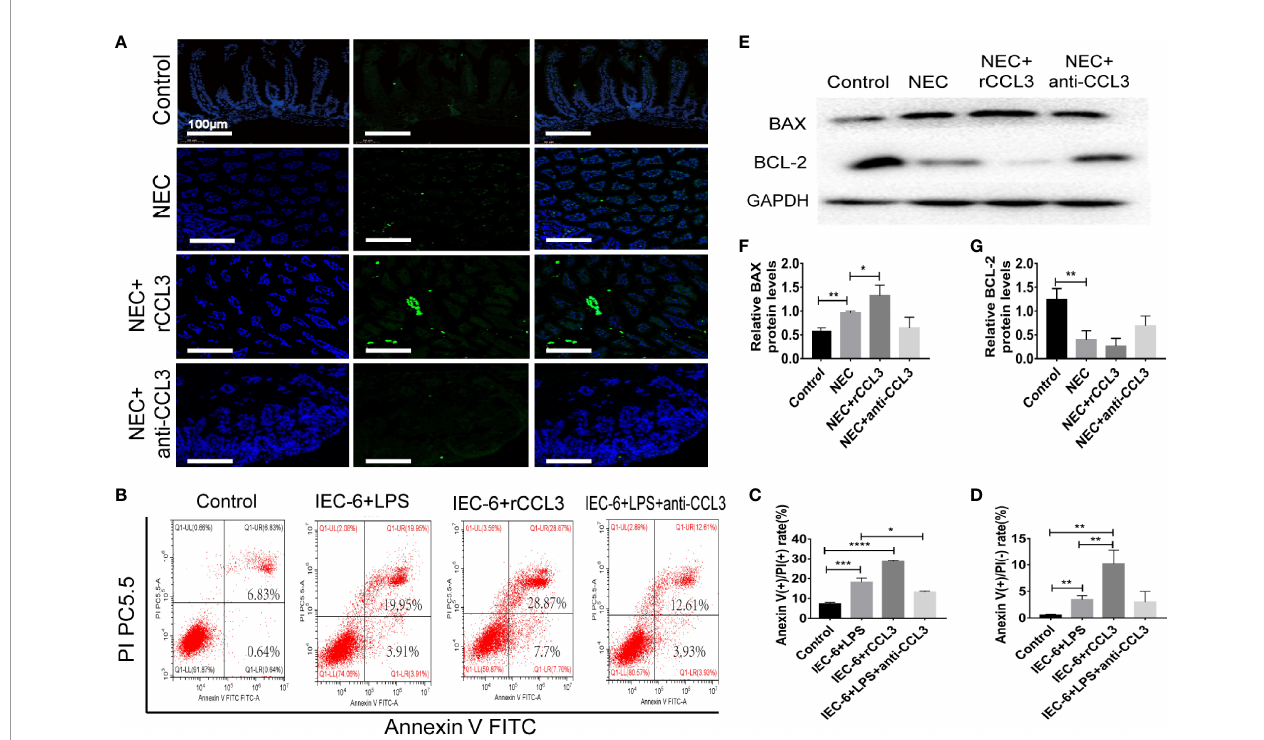
FIGURE 3 | CCL3 aggravates the apoptosis of intestinal epithelial cells. (A) Representative images of TUNEL (FITC) stained sections from control, NEC, NEC +rCCL3, NEC+anti-CCL3 groups (Scale bar =100 m m). (B-D) IEC-6 cells were pretreated with rCCL3 (50 ng/mL), anti-CCL3 (50ng/ml) for 24h and exposed to 100 m g/ml LPS for 4 h. Flow cytometry (FCM) was performed to evaluate the effects of rCCL3 and anti-CCL3 on the apoptosis of the IEC-6 cells. Data are expressed as mean ± SD. *p < 0.05, **p < 0.01, ***p < 0.001, ****p < 0.0001 when compared between groups. (Mann-Whitney U test) (E-G) The protein level of BAX and BCL-2 were assessed by Western blotting and the intensity was analyzed (n =4-6/group). Three independent experiments were performed. Data are expressed as mean ± SD. *p < 0.05, **p < 0.01 versus control or intervention groups (Mann-Whitney U